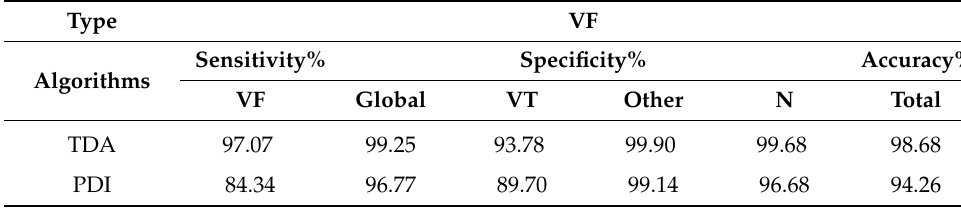
Table 6. Results obtained for VF class classification in testing.